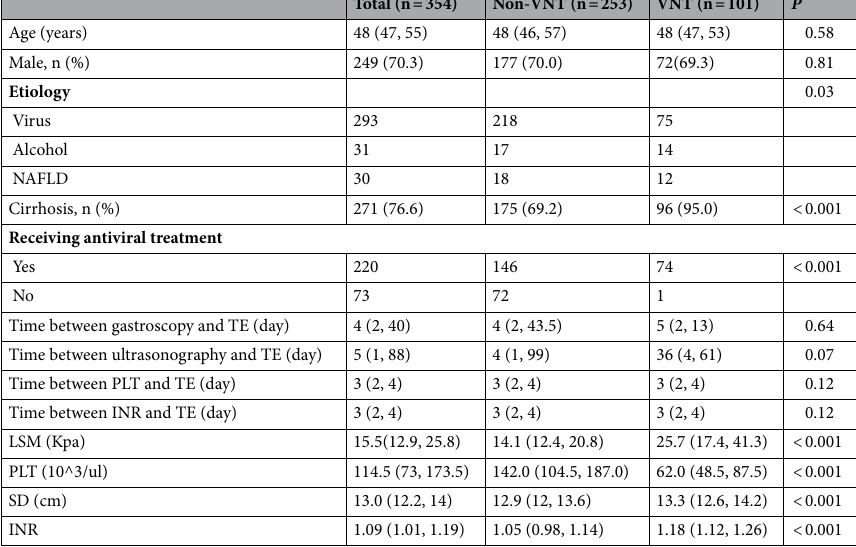
Table 1. Baseline characteristics of the study populations. VNT, varices needing treatment; TE, transient elastography; PLT, platelet count; LSM, liver stiffness measurement; SD, spleen diameter; INR, international normalized